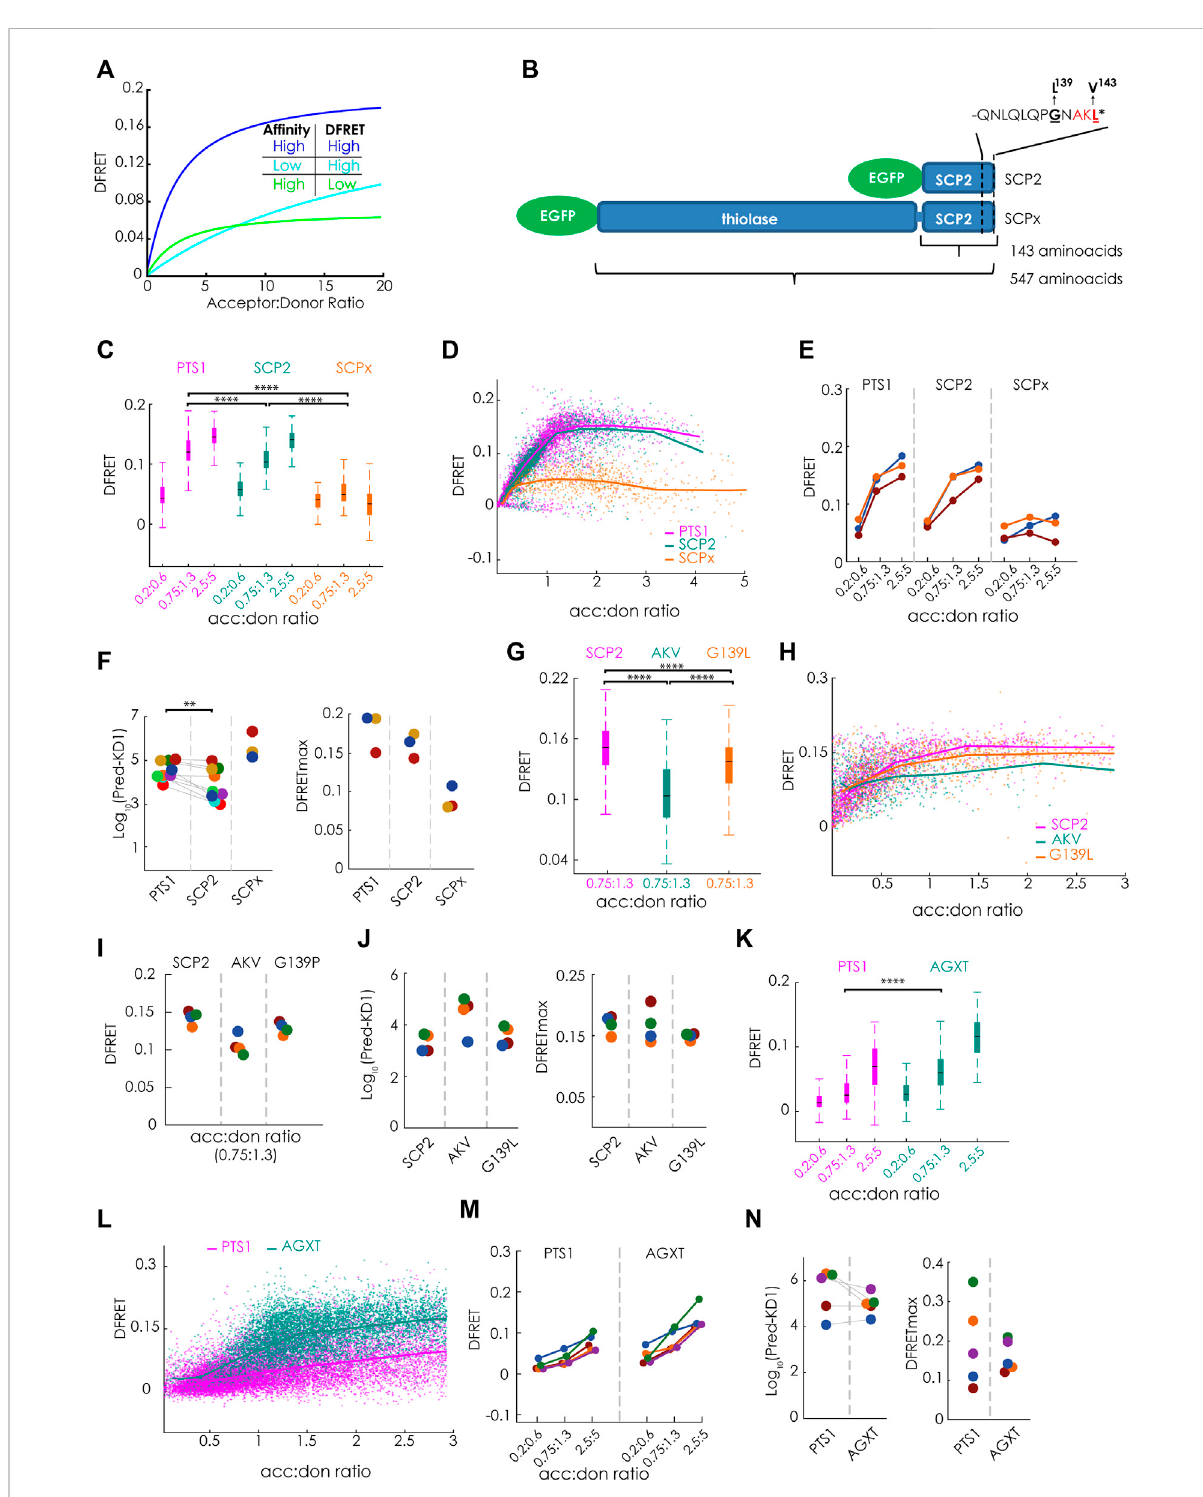
FIGURE 2 Bimolecular fl owFRET analysis ofproteincomplexesinvolving large proteins or low af fi nity binding partners: (A) Traditionallimitations of FRET- measurements are protein complexes involving large proteins (low DFRETmax) (green) or low af fi nity binding partners (cyan) compared to complexesinvolvingsmallproteinswithhighaf fi nity(blue); (B) SchematicdepictionofthePTS1-carryingmurineproteinsSCPxandSCP2sharingthe same C-terminal domain, but differing in protein size due to an additional thiolase domain in SCPx, the last 12 amino acids encoding the PTS1 (PTS1(SCP2)) are depicted separetely; (C – N) pex5 − / − MEF expressing mCherry-PEX5(TPR) as acceptor and various EGFP-tagged donor molecules